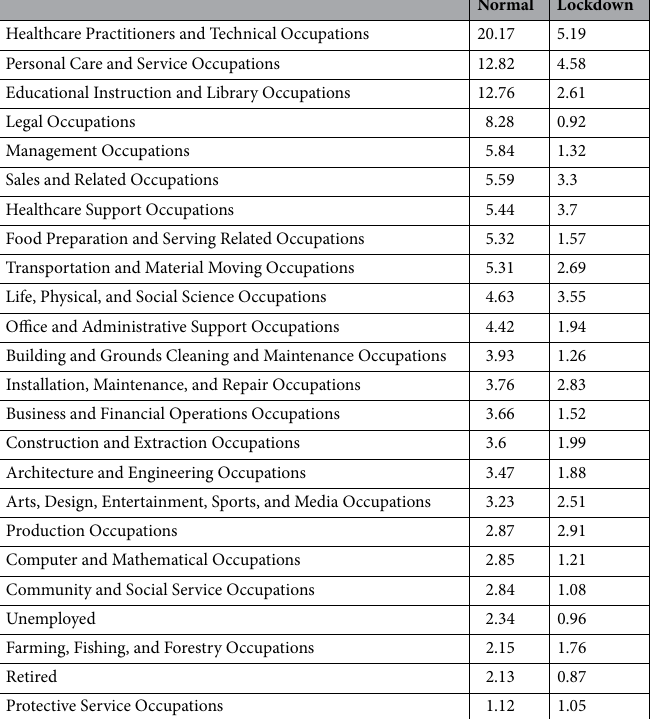
Table 1. Mean degrees per major occupational group for empirical networks at time points prior to (normal) and during the first COVID-19 lockdown in Spring 2020.